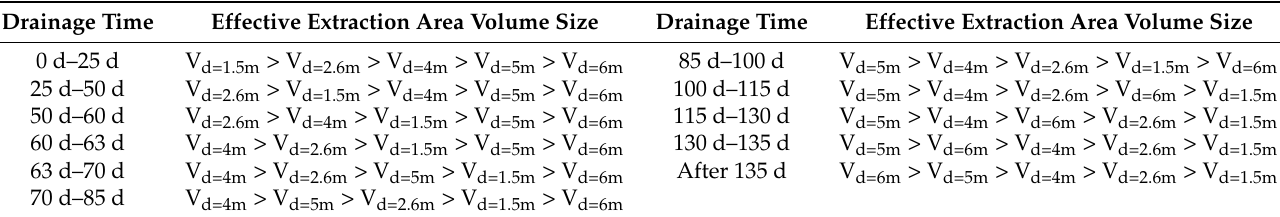
Table 2. Table of parameters required for